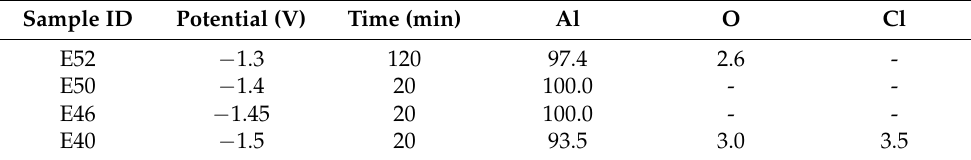
Table 1. EDS chemical composition (wt.%) of coatings deposited at different